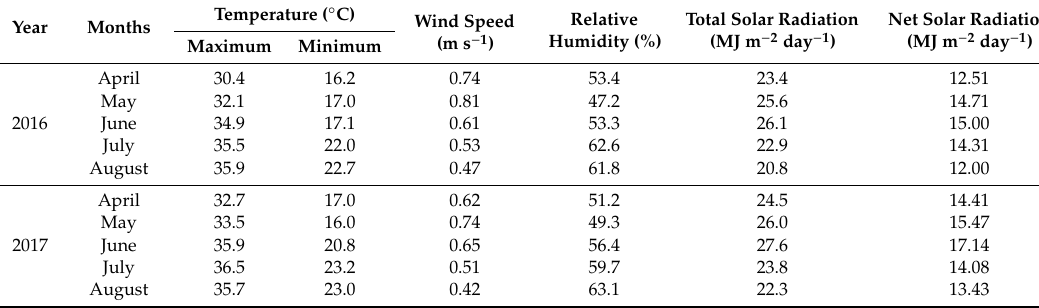
Table 1. Monthly agro-climatological data in the Sadat city region (30 ◦ 2 (cid:48) 41.2” N, 31 ◦ 14 (cid:48) 8.2” E) in the 2016 and 2017 growing